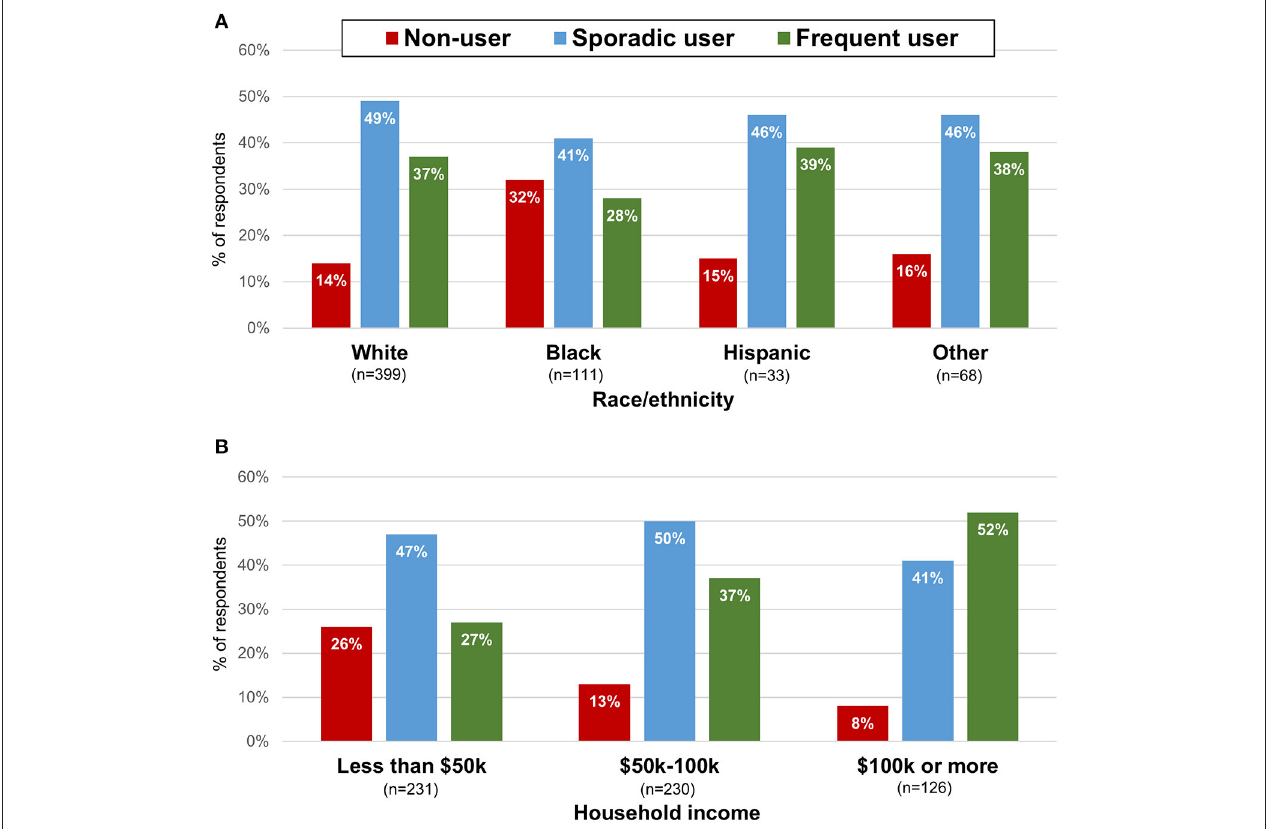
FIGURE 1 | Differences in pre-COVID-19 use of outdoor park spaces by (A) race/ethnicity ( X 2 (6) = 18.5, p = 0.002, Cramer’s V = 0.123), and (B) household income ( X 2 (4) = 35.5, p < 0.001, Cramer’s V = 0.174). Data are based on an August 2020 survey of urban residents in NC ( n = 611).